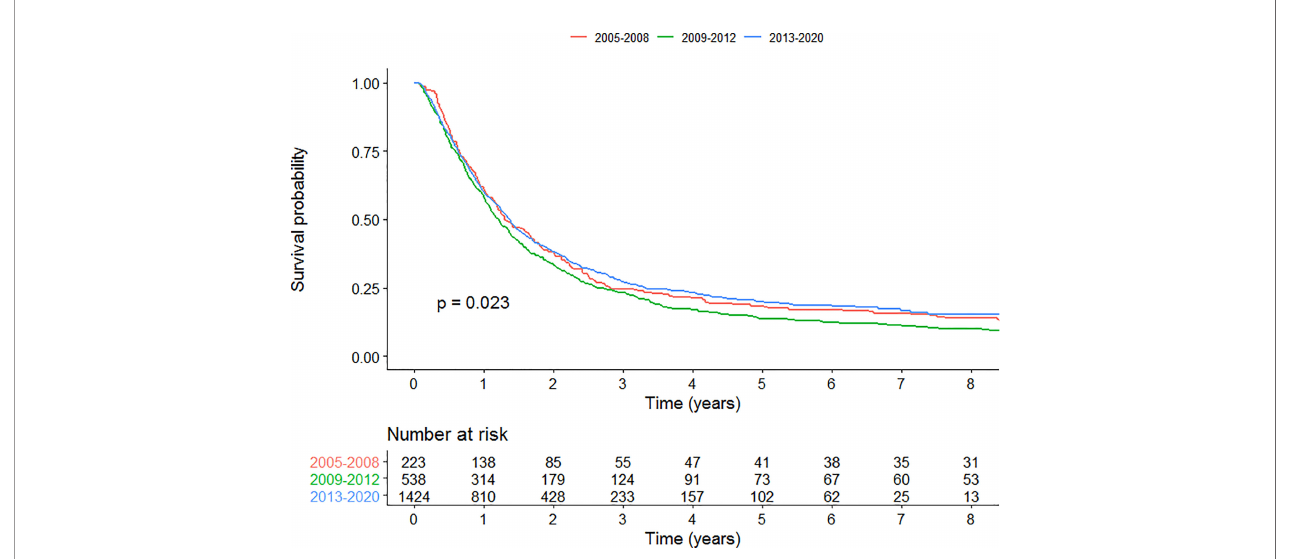
FIGURE 7 | Kaplan-Meier survival curves for each time period for patients with stage III disease curative-intent